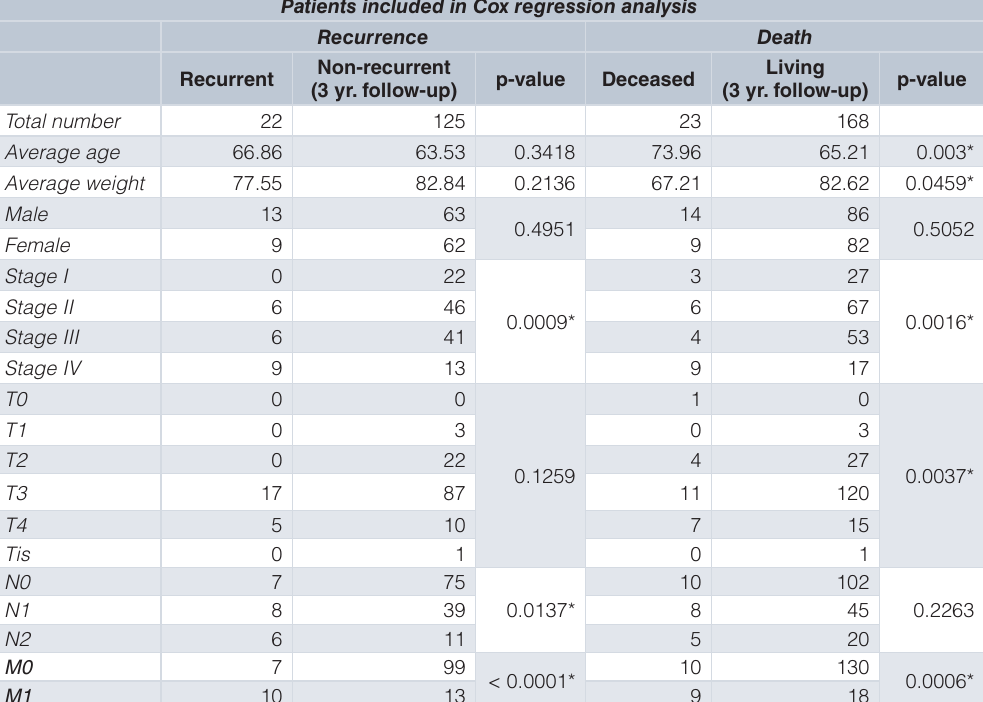
Table 2. Characteristics of patients with RPPA data included in Cox regression analysis for death and